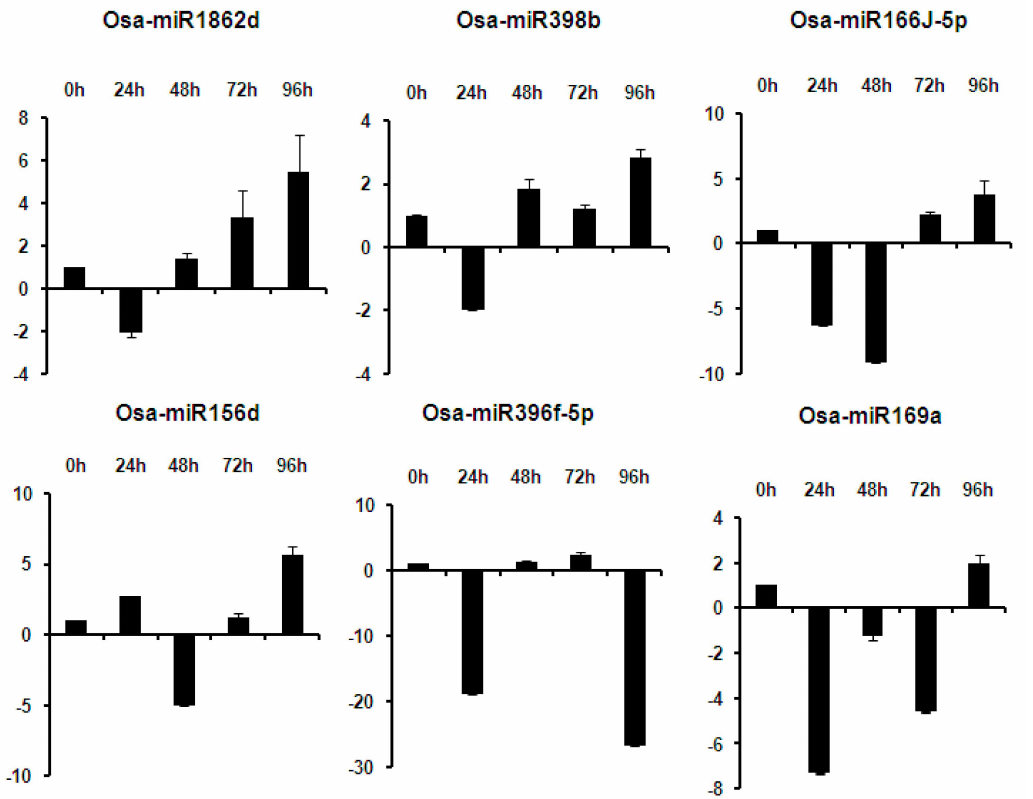
Figure 4. Expression analysis of miRNAs and their target genes. miRNAs and their respective target genes expressing under R. solani infection were quantitatively analyzed through RT-qPCR. Data represented after internal reference genes U6 (for miRNAs) and OsActin1 (for target genes) normalization. The error bars represent the standard error of three biological replicates. X -axis: samples and Y -axis: fold change expression in the fungal-infected sample in comparison to the control. Bars represent miRNAs, while lines represent target genes expression.